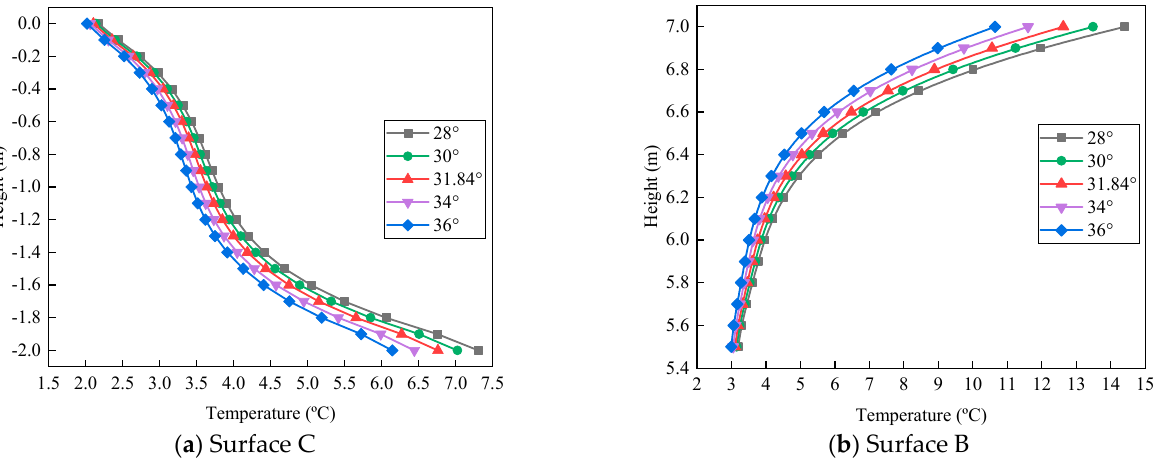
Figure 22. Temperature gradient with different geographic latitudes. The temperature gradients with different directions of the aqueduct are shown in Figure 23. It can be concluded from Figure 23 that the direction of the aqueduct has limited influence on the top half of the surface B as they are adjacent to the top surfaces whose temperatures are scarcely influenced by the direction of the aqueduct. The maximum temperature change is 0.5 ◦ C, appearing when the direction of the bridge turns clockwise by 15 ◦ . It is interesting to find that the temperature gradients almost stay unchanged when the surface azimuth is bigger than 301 ◦ . The reason for this phenomenon may be that sunlight on the western surfaces stays unchanged when the azimuth is larger than a certain angle.